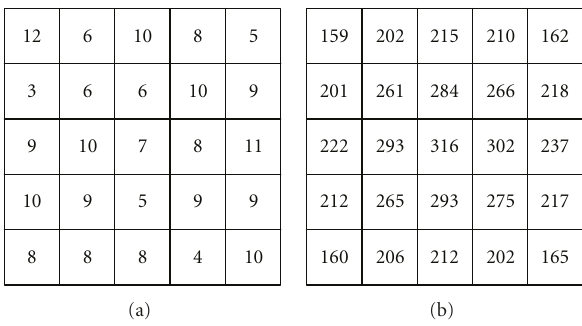
Figure 3: An example of multi-hop tra ffi c-flow weight.